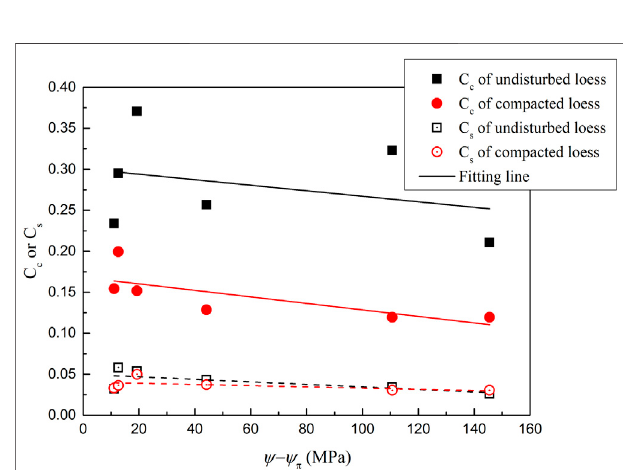
FIGURE 7 | The Δ e underimpactoftotalsuctionandosmoticsuction: (A) the Δ e versus Ψ at the second stage; (B) the Δ e versus Ψ - Ψ π at the third stage.